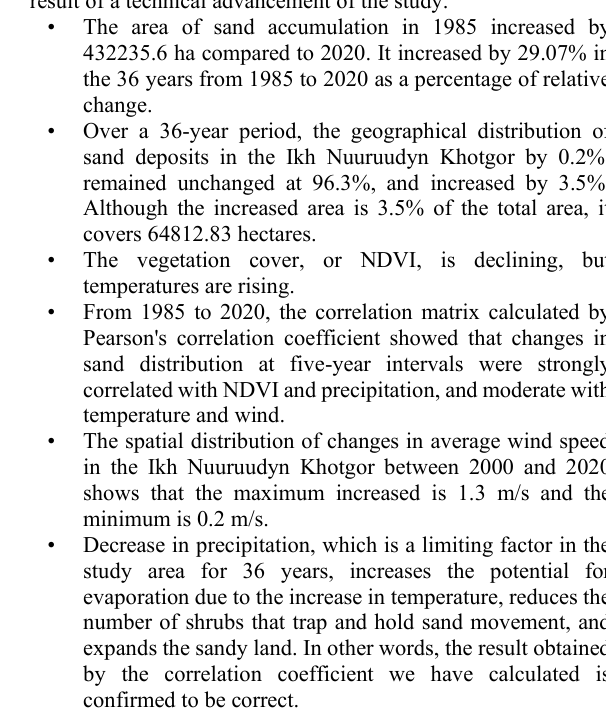
Table 4. Temperature change.